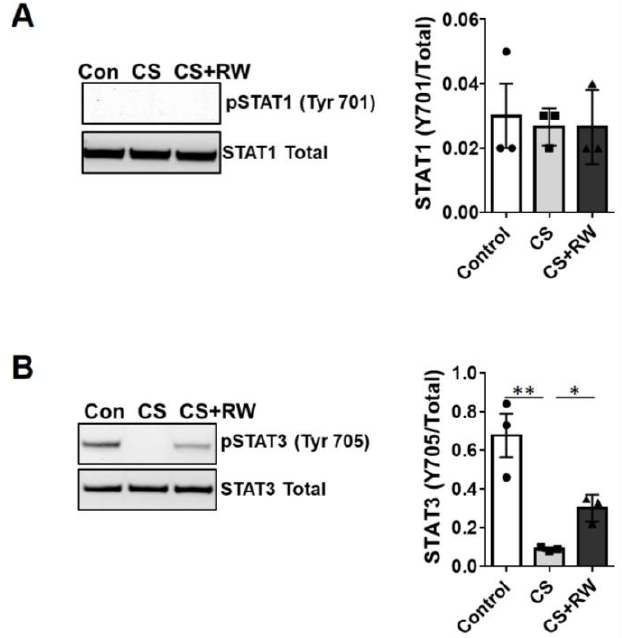
Figure 7. In vitro cold storage plus rewarming reduces STAT3 phosphorylation in human renal cells. ( A , B ) HK-2 cells were cultured and underwent 18 h CS or 18 h CS plus 6 h rewarming (CS + RW or +RW). Extracts were prepared using a RIPA lysis method (see Section 4). 20 μ g renal cell extract protein samples were resolved with SDS-PAGE and analyzed via Western blot for phosphorylated and total levels of ( A ) STAT1 and ( B ) STAT3 after CS or CS + RW. Data are the mean ± SEM (bars, n = 3) with representative blots displayed. Differences between group means were compared with 1-way ANOVA followed by Brown – Forsythe and Welch’s correction for multiple group comparisons; p < 0.05 was considered significant. *, p < 0.05; **, p < 0.01. Each solid circle, square, or triangle represent each experiment analysis (biological replicates) within the group.